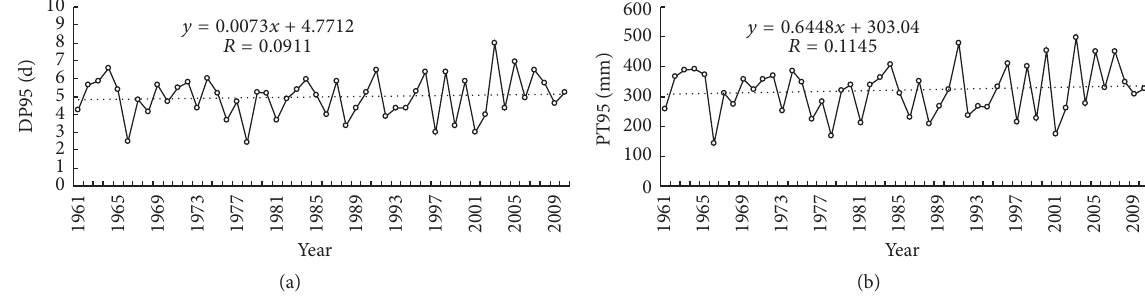
Figure 9: Temporal changes of extreme precipitation days (a) and extreme precipitation total (b) in the HRB.